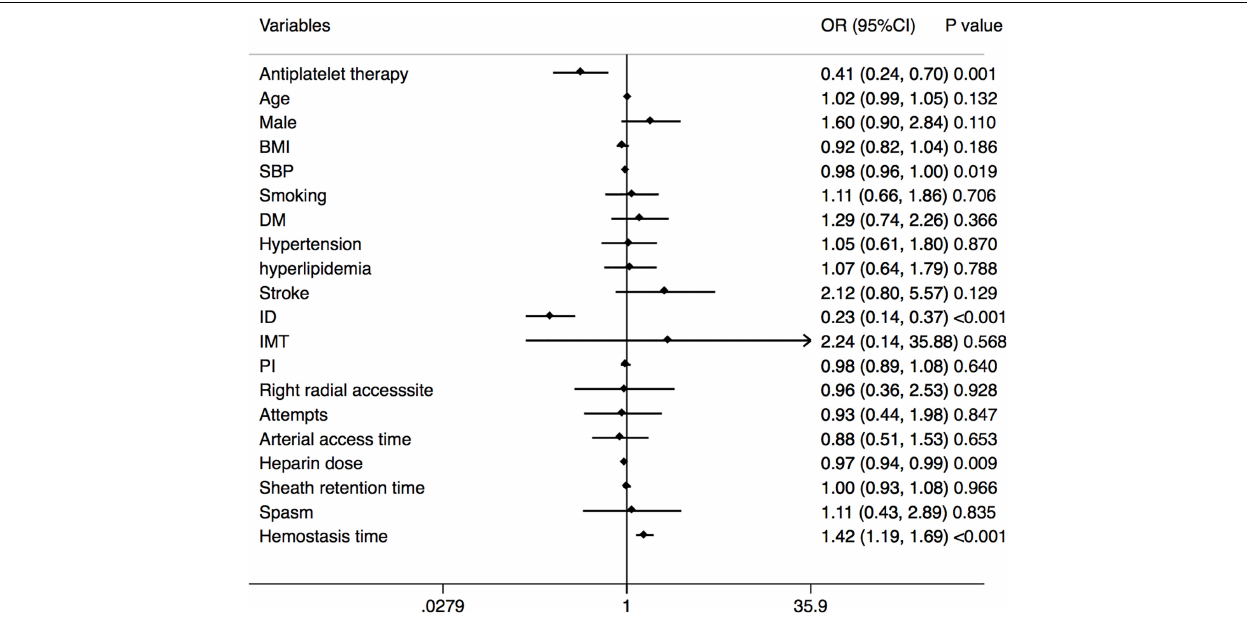
FIGURE 4 | Forest plot of the multivariable logistic regression analysis model exploring the predictors of RAO at 30 days after the TRCA. RAO, radial artery occlusion; TRCA, transradial coronary angiography; BMI, body mass index; SBP, systolic blood pressure; DM, diabetes mellitus; ID, inner diameter; IMT, intima-media thickness; PI, pulsatility